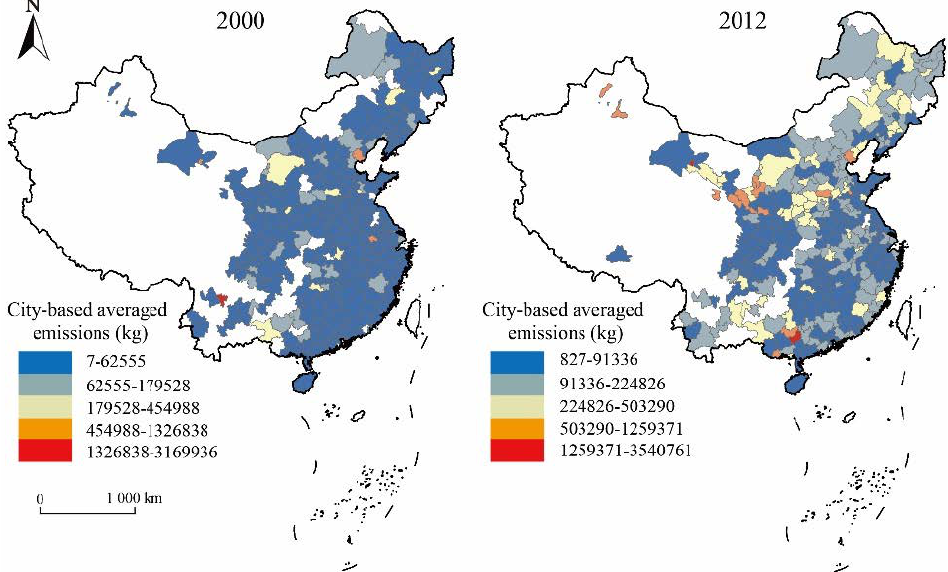
Figure 1. Spatial distribution of emissions from Chinese industrial firms in 2000 ( left ) and 2012 ( right ).